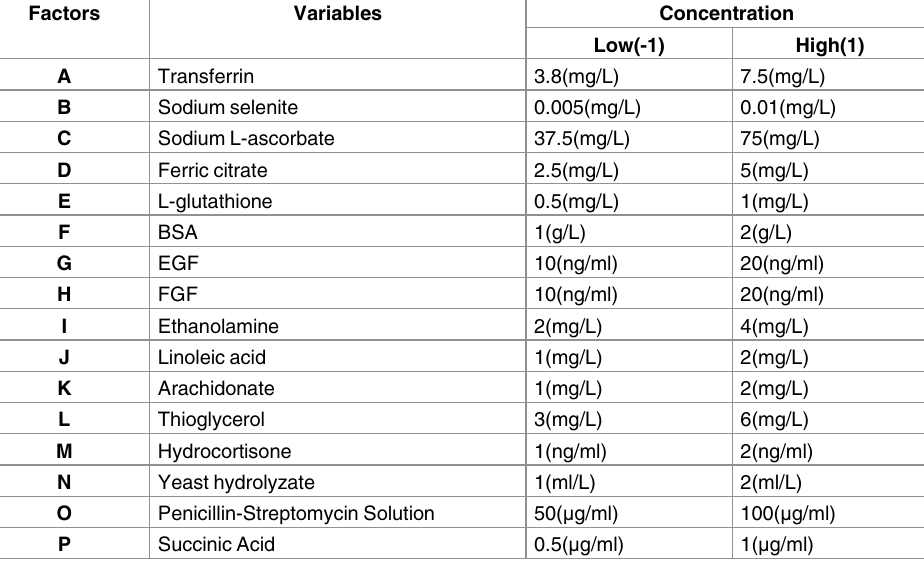
Table 1. Factors and their corresponding concentrations by Plakett-Burman